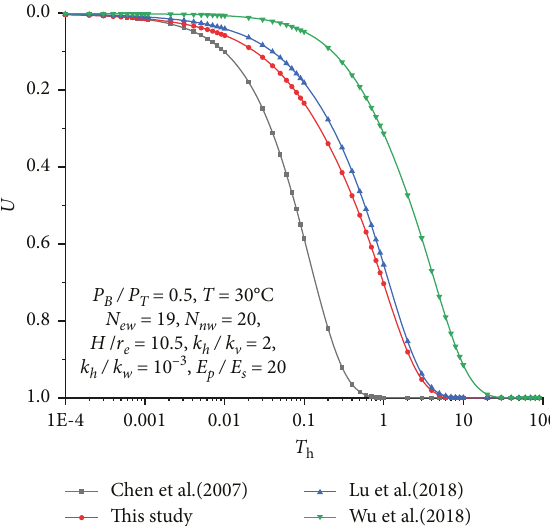
Figure 8: Comparison of consolidation of four models.